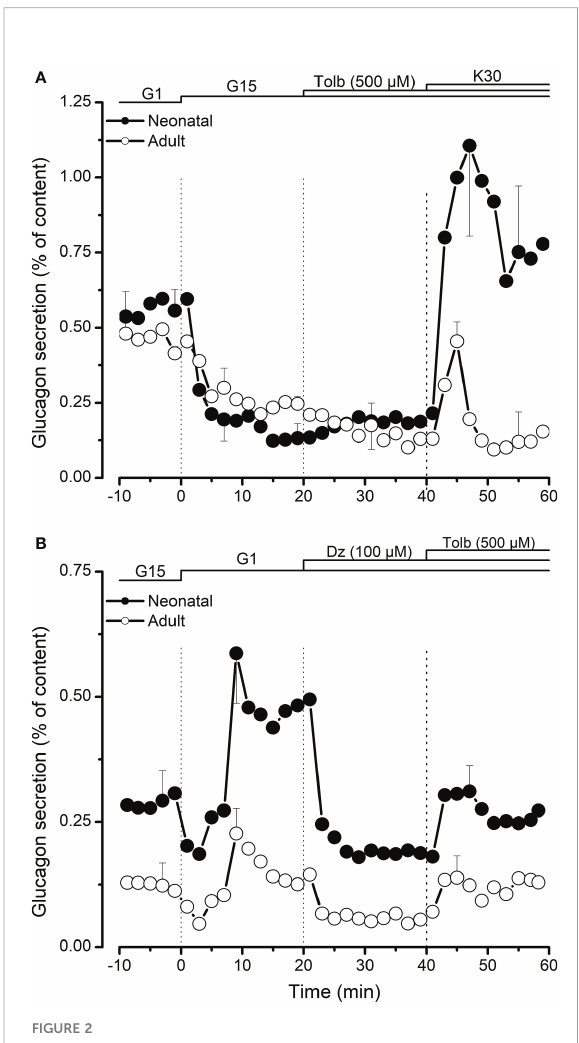
FIGURE 2 Role of K-ATP channels in regulation of glucagon secretion from neonatal ( ● ) and adult ( ○ ) porcine islets. In (A) , the effect of K- ATP channel blocker, tolbutamide (Tolb, 500 µM) was studied in the presence of high glucose (15 mM, G15). 30 mM KCl (K30) was added at the end to test the effect of membrane depolarization on glucagon secretion. In (B) , the effects of tolbutamide and K-ATP channel activator, diazoxide (Dz, 100 µM) were studied in the presence of low glucose (1 mM, G1). Values are means ± SEM from n=3 different preparations from each age